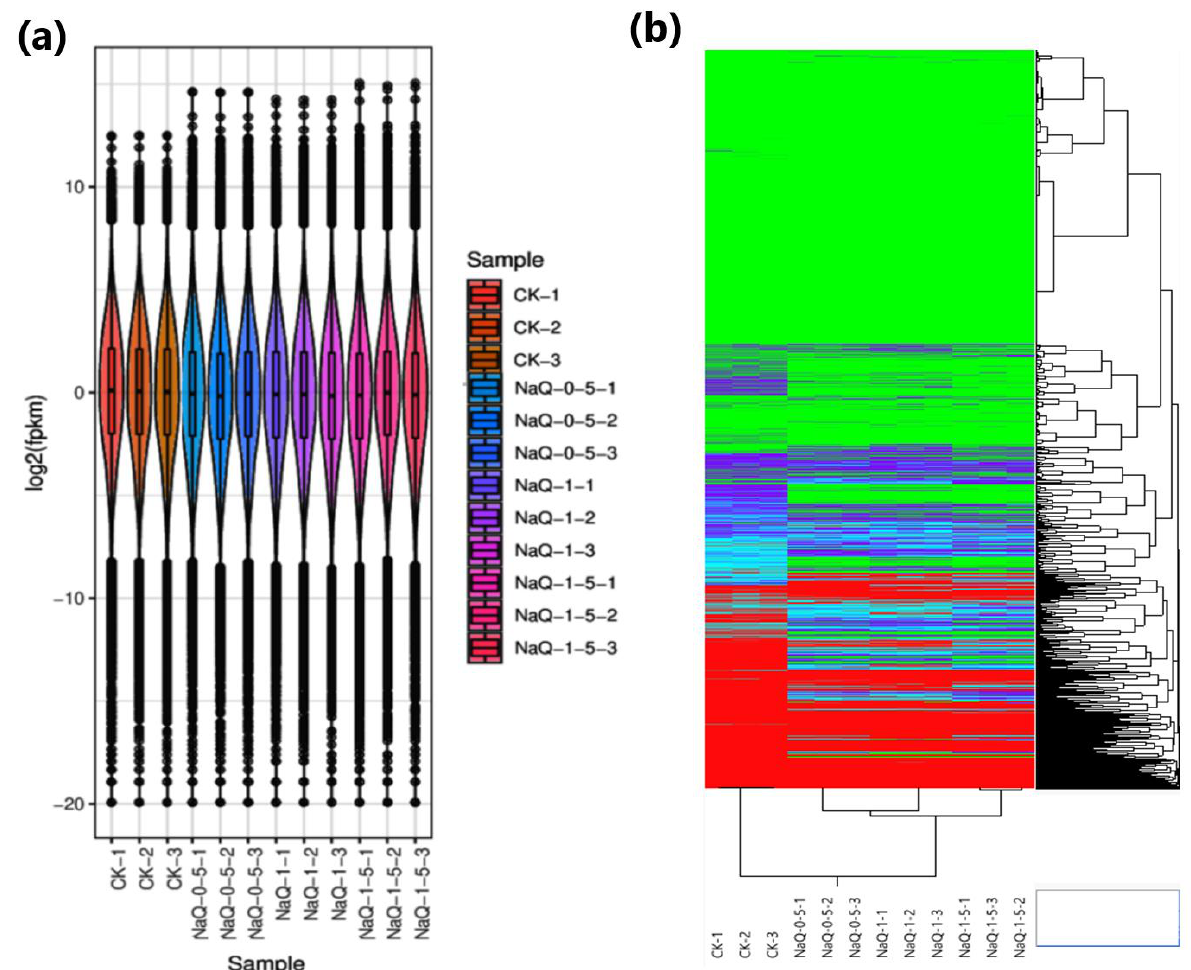
Figure 2. Quality control of transcript data demonstrated as violin plots ( a ) and a correlation matrix ( b ) of control (CK) and different NaCl (3%) treatments for 0.5, 1, and 1.5 h on triplicated cotton seedling samples. CK: no treatment; N0.5: NaCl treatment for 0.5 h, N1: NaCl treatment for 1 h, and N1.5: NaCl treatment for 1.5 h; -1,2,3 representing